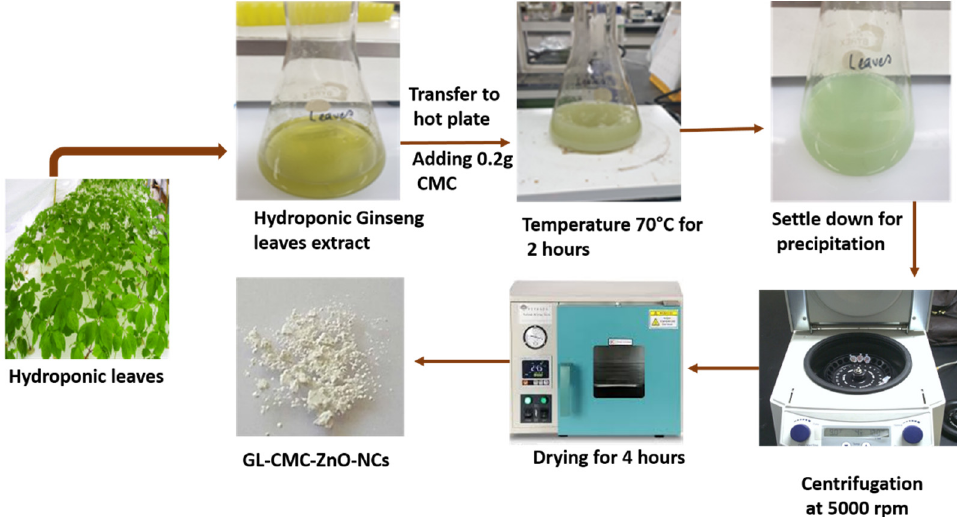
Figure 1. Synthesis method for the preparation of GL–O-carboxymethyl chitosan (CMC)–ZnO nanocomposites (NCs) using hydroponic fresh ginseng leaves with CMC.